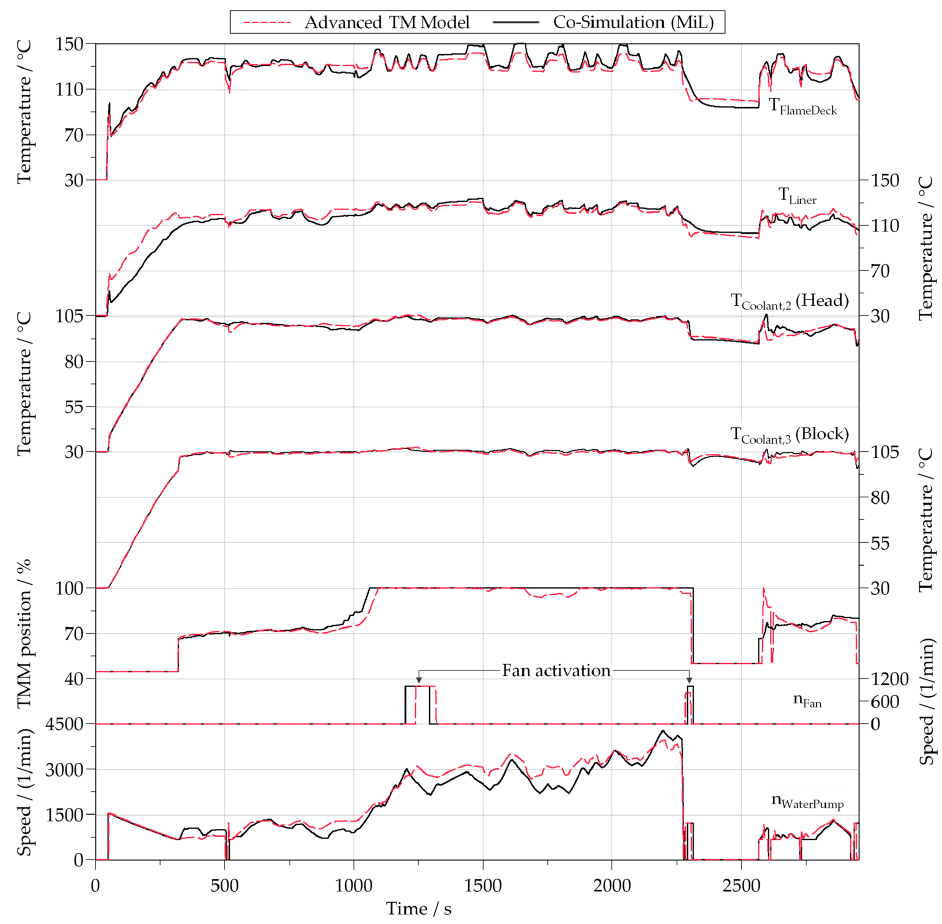
Figure 14. Großglockner High Alpine Road simulation results at 30 °C ambient temperature.